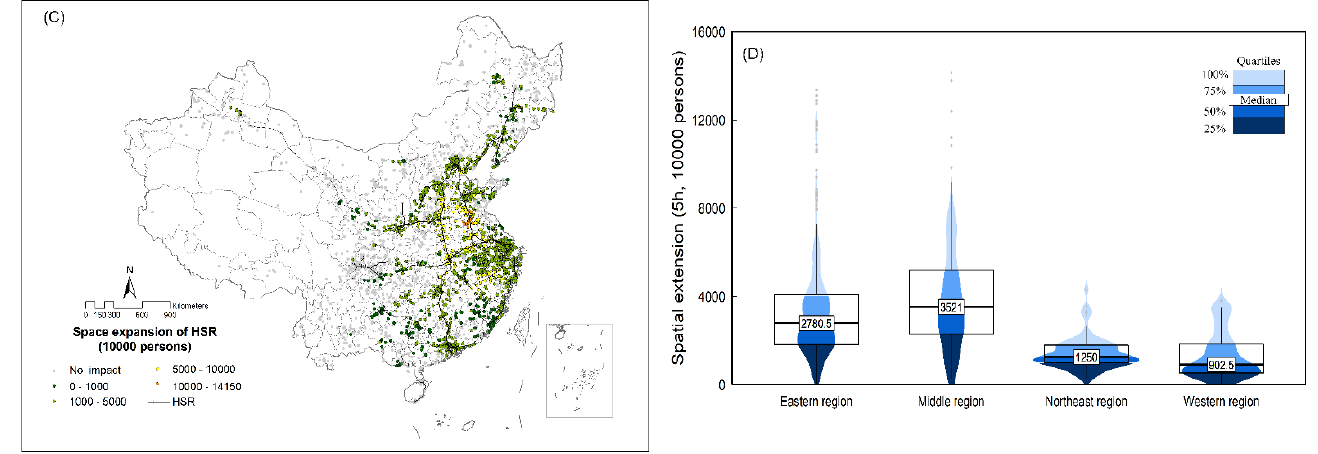
Figure 5. SE effect of HSR on tourist destinations. ( A – C ) represent the SE effect under temporal distance of 3 h, 4 h and 5 h respectively during 2008–2019. ( D ) shows the Violin Plot of SE effect of HSR in four regions of China (5 h). Table 2. Results of panel unit root test for different scenarios.